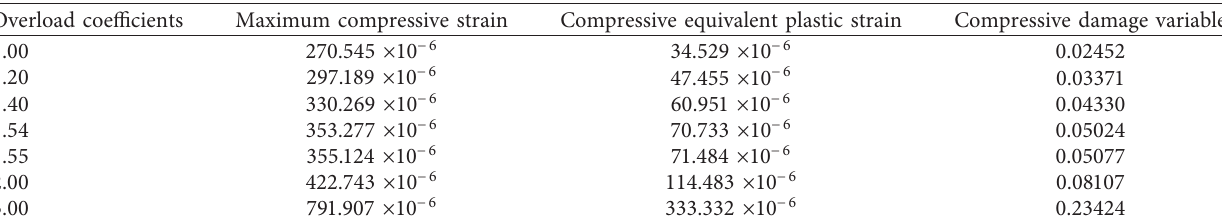
Table 3: The related variable values of the element 1327 near the dam toe in the time history under different overload coefficients. Overload